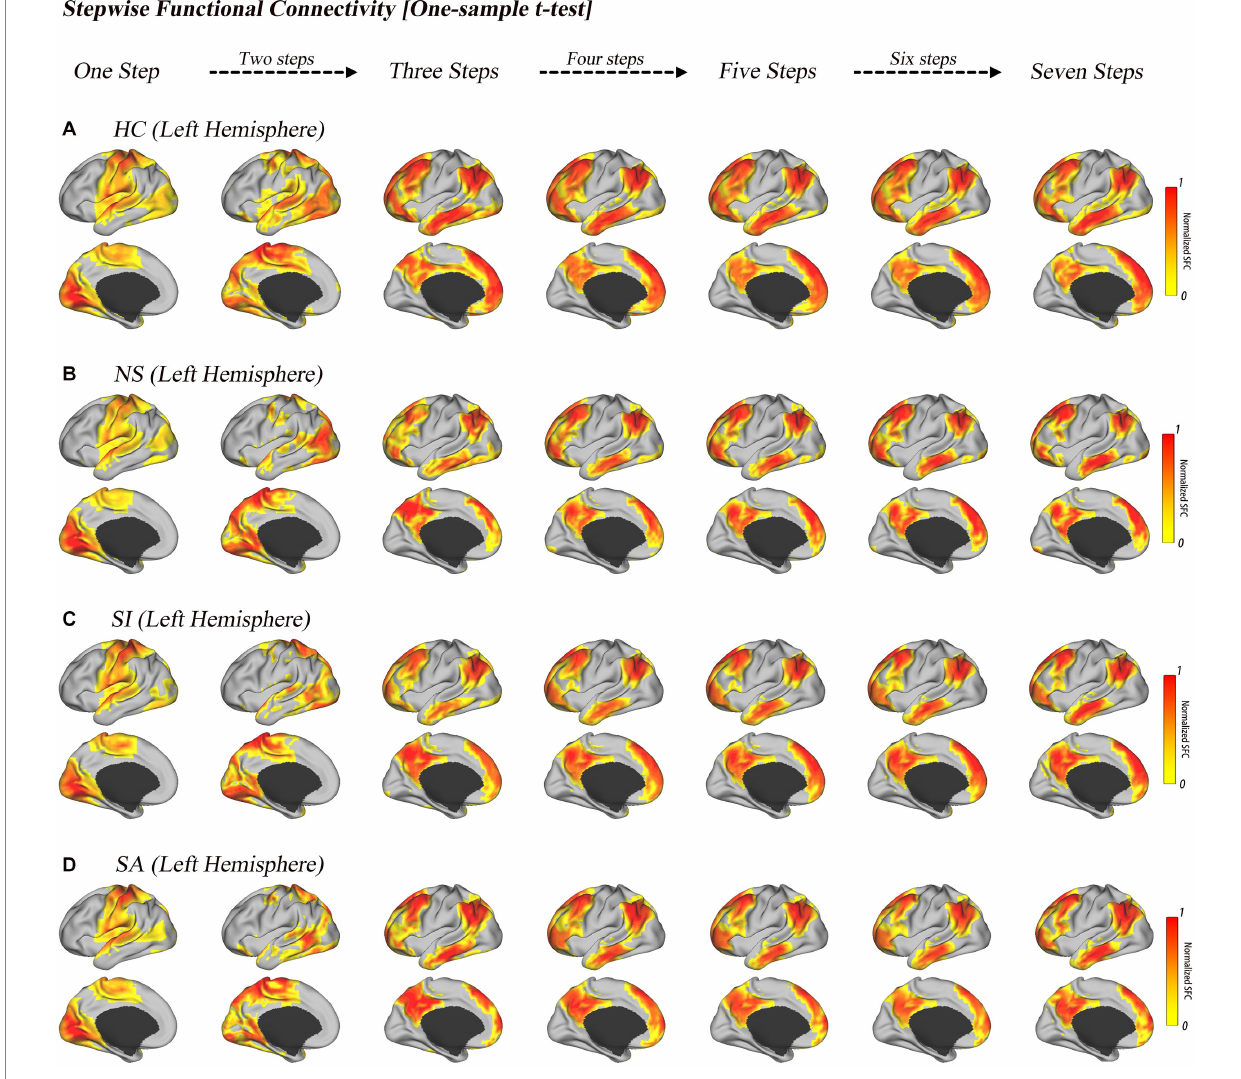
FIGURE 2 Stepwise functional connectivity pattern in HC and MDD with diverse suicide risks. Surface projections of the one-sample t -test results of the unimodal-to-transmodal link-step distances for HC (A) , NS (B) , SI (C) , and SA (D) . All of the results are displayed after multiple comparison correction ( p < 0.0001, FDR corrected). The color bar represents the normalized color scale, 0 represents non-significant results, and 1 is the maximum value corresponding to the smallest p